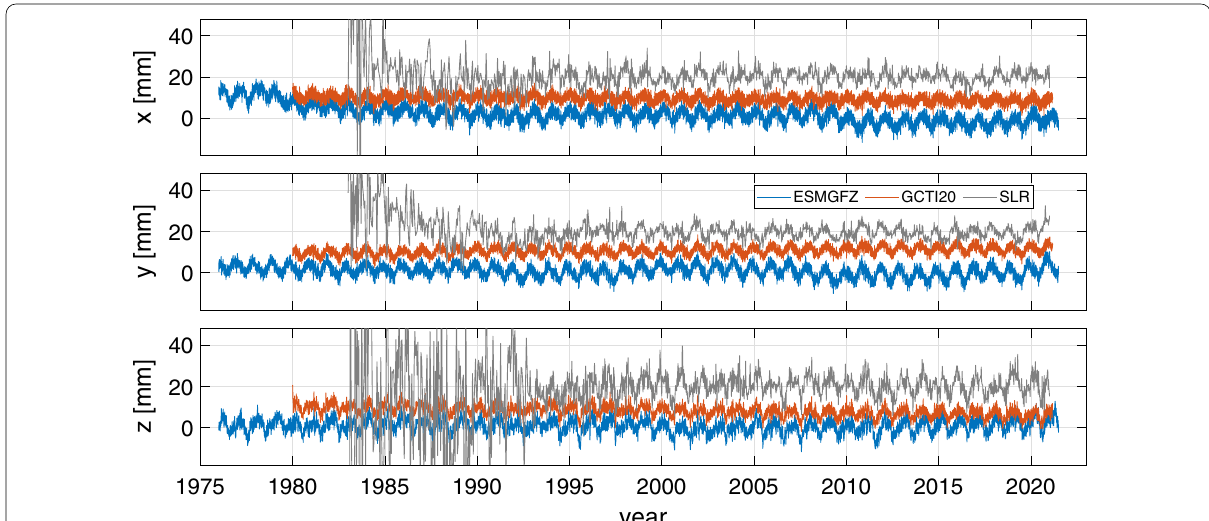
Fig. 9 Geocentre motion contributions as computed for the combined loading of both GCTI20 (NTAL NTOL HYDL SLEL, blue). For comparison, also the geocentre motion estimated by SLR is shown (grey). The time-series for GCTI20 and SLR have + + been shifted by 10 and 20 mm, respectively